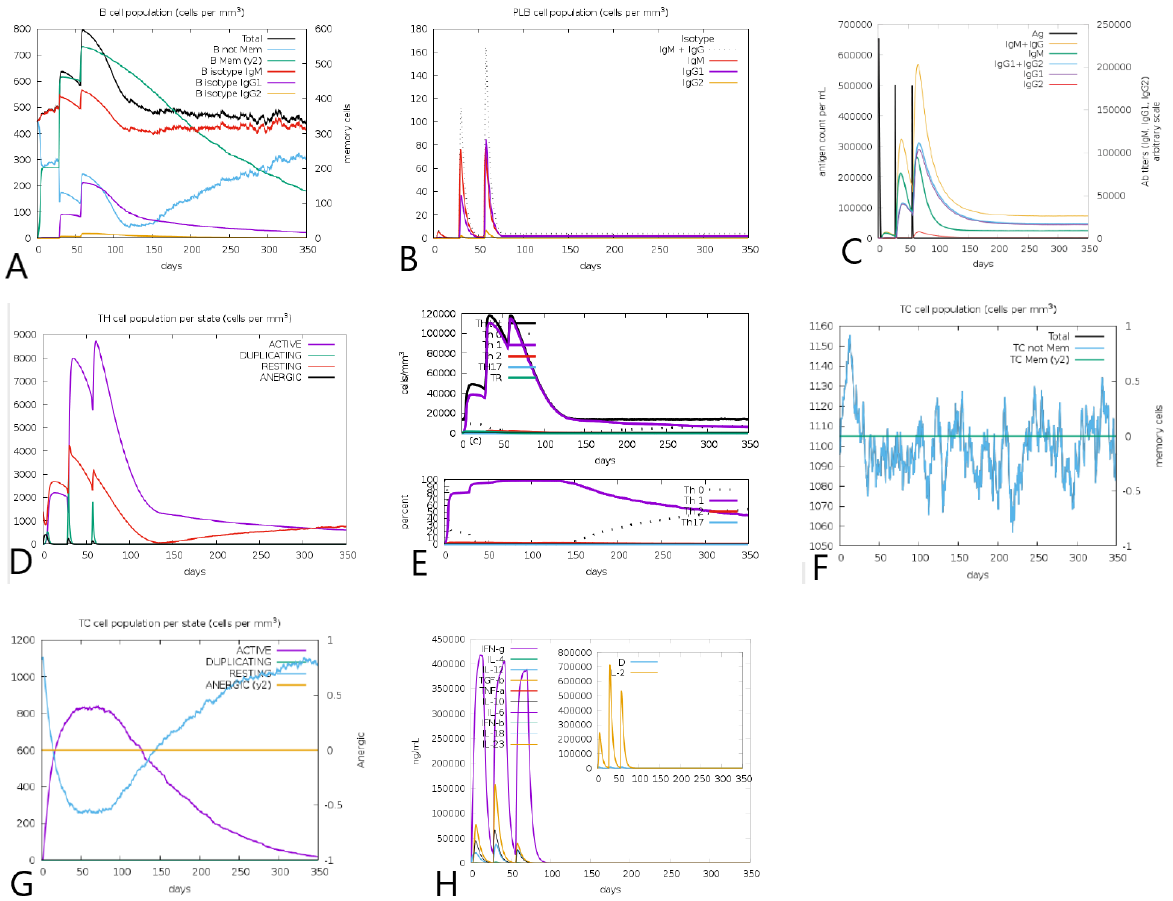
Figure 5. Immuno simulation results of the Tpme-VAC/LGCM-2022 regarding: ( A ) B cells population per mm 3 ( B ) PLB cell population per mm 3 . ( C ) Immunoglobulin production. ( D ) Helper T-cell population per state. ( E ) I Helper T-cell differentiation. ( F ) Cytotoxic T-cell population. ( G ) Cytotoxic T-cell population per state. ( H ) Cytokine production.